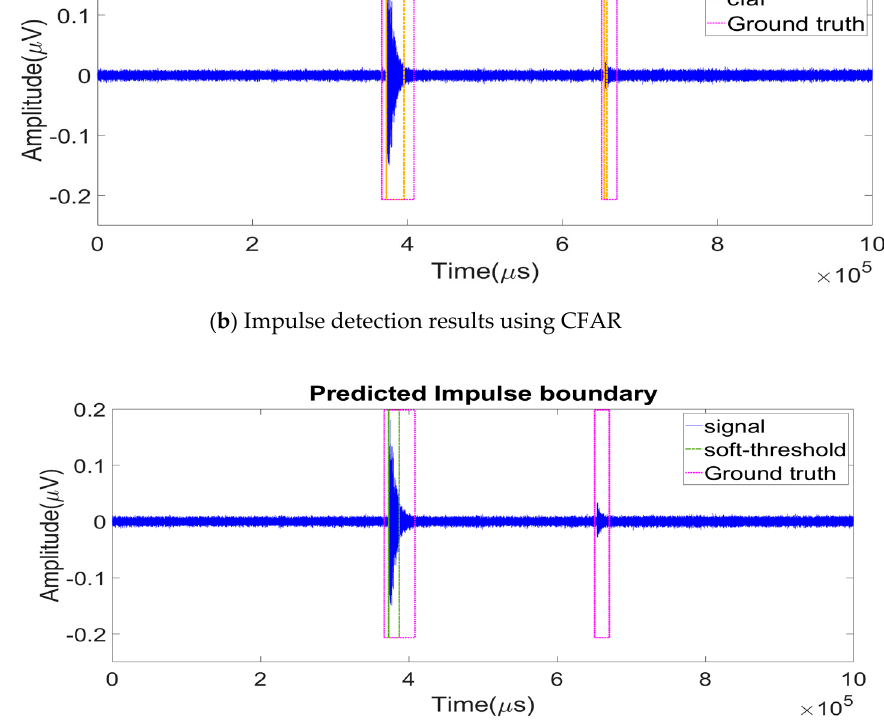
Figure 7. Performance of impulse detection for different algorithms: ( a ) proposed DLFBR method, ( b ) constant fault alarm rate (CFAR) method, and ( c ) soft threshold method.